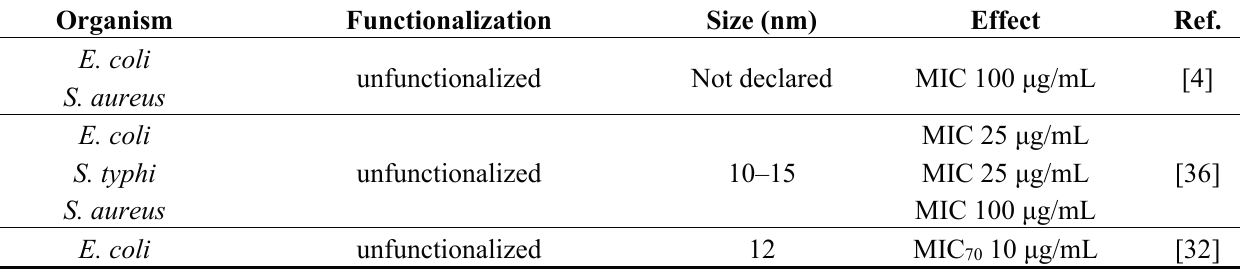
Table 2. Selected studies on the antibacterial activity of silver